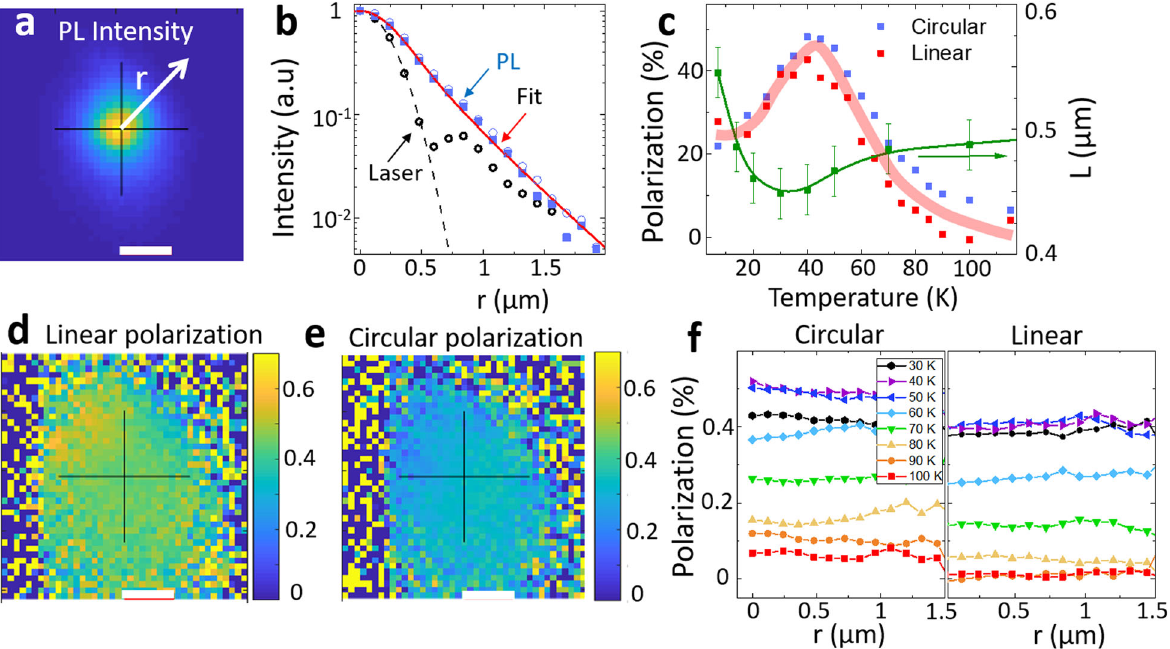
Fig. 2 Imaging the spatial distribution of excitons and their valley index. a Spatially resolved PL intensity under cw laser excitation at 5 μ W at T = 6 K. The radial distance with respect to the excitation spot is denoted by r . The length of the scale bar is 1 μ m. b Radial pro fi le of the PL intensity shown in ( a ) obtained after averaging over different directions, for a circular (squares) and linear (open circles) laser excitation. Also shown is the laser pro fi le (black circles) together with a Gaussian pro fi le (dashed black line) with a radius of 0.3 μ m. The red line is a fi t with a solution of the 2D diffusion equation (Eq. (1)) giving an effective diffusion length of L = 0.55 ± 0.025 μ m. c Degree of polarization under circular and linear excitation for an excitation power of 20 μ W as a function of sample temperature. Also shown is the effective diffusion length L extracted from the spatially resolved PL images. Continuous lines are a guide to the eye. d Spatially resolved linear polarization under linear excitation for the same conditions as ( a ). Same scale as in ( a ). e Spatially resolved circular polarization under circular excitation for the same conditions as ( a ). Same scale as in ( a ). f Radial pro fi le of the photoluminescence ’ s circular and linear polarization for selected values of the sample temperature. The laser excitation is kept at 20 μ